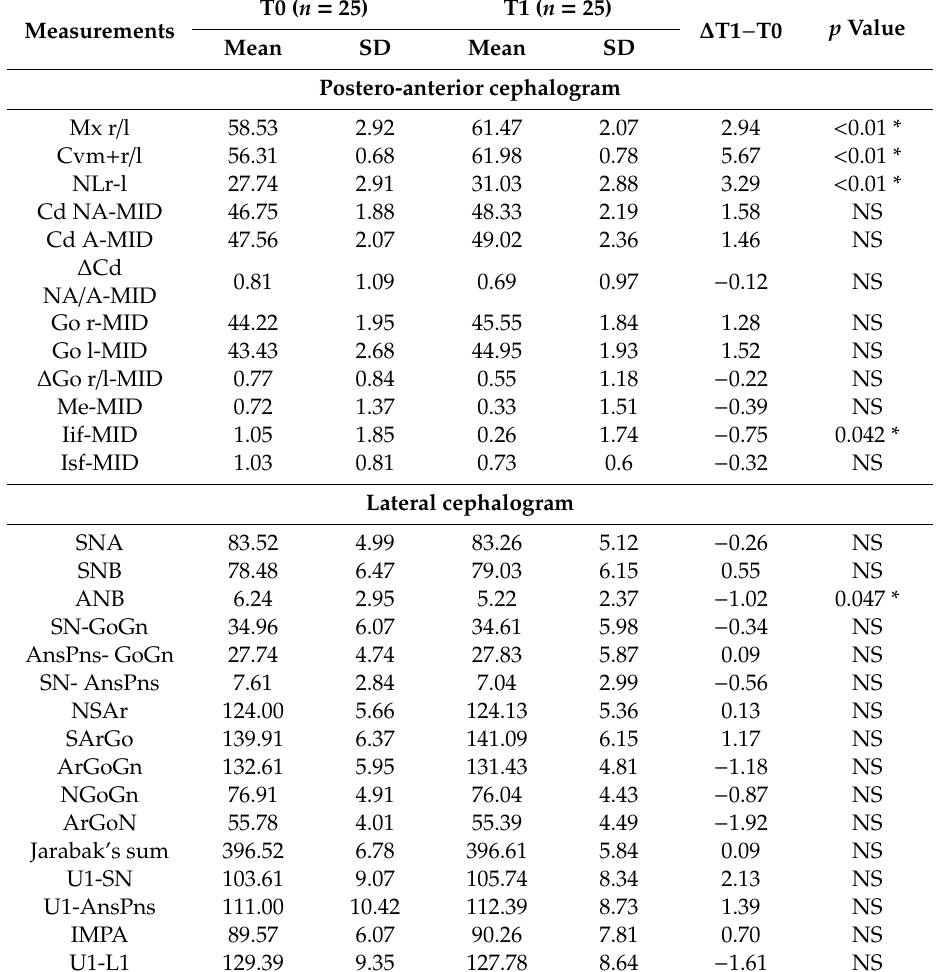
Table 3. Control group. Mean, standard deviation (SD) and comparisons between pre-treatment (T0) and post-treatment (T1) values with paired t-test in non-JIA control